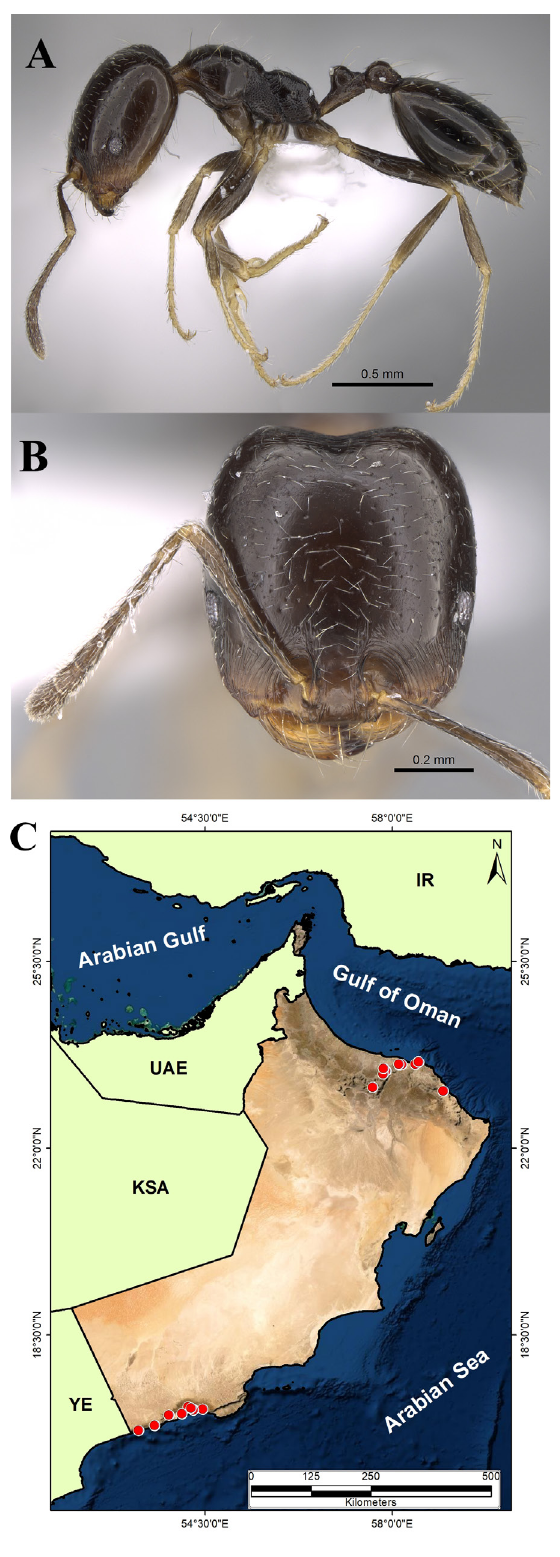
Fig. 51. Trichomyrmex mayri (Forel, 1902), worker (CASENT0922869, AntWeb.org (Michele Esposito)). A . Body in profile. B . Head in full-face view. C . Distribution